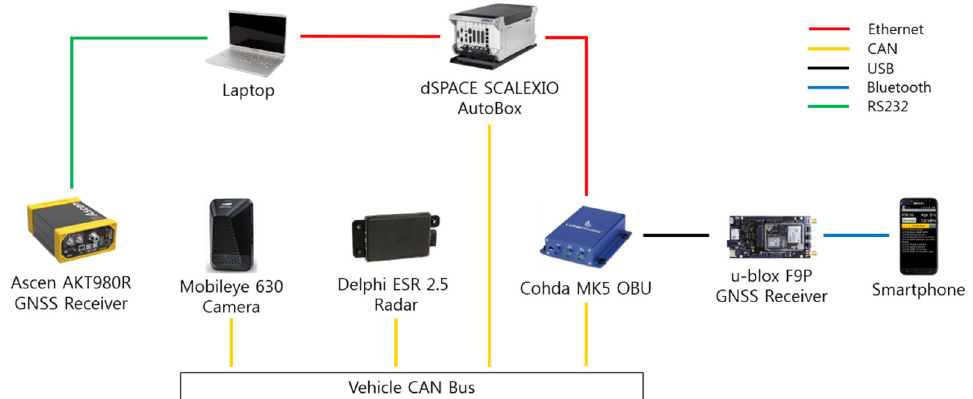
Figure 7. Overview of the hardware interface.